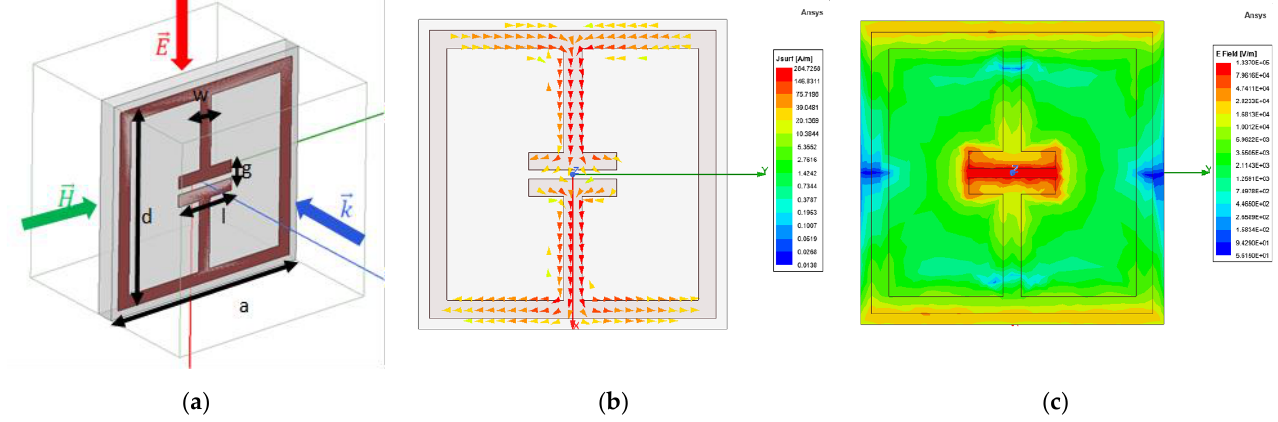
Figure 3. ( a ) HFSS unit cell model ( b ) Surface current density ( c ) Electric field distribution.